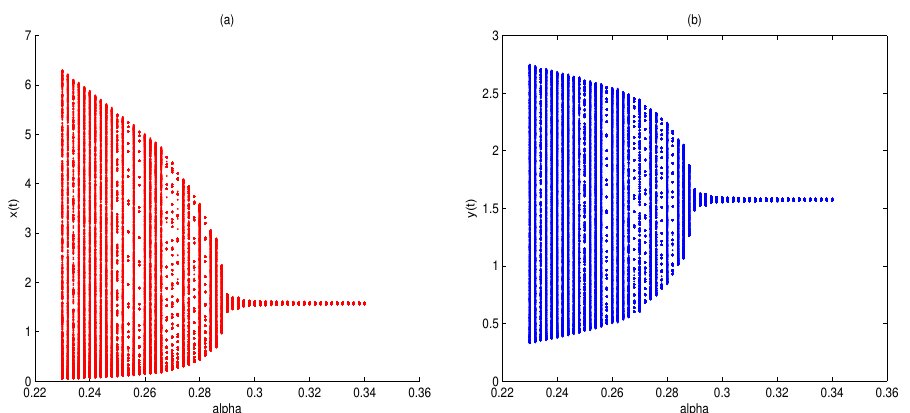
Figure 7. There is a supercritical Hopf bifurcation when η passes through 0, i.e., α passes through 0.288. Here r = 1.888, ω = 0.9, b = 1, c = 1.213, A 1 = ( 1.574,1.574 ) . Figure ( a ) is a biurcation diagram of x ( t ) with respect to α , and Figure ( b ) is a bifurcation diagram of y ( t ) with respect to α .